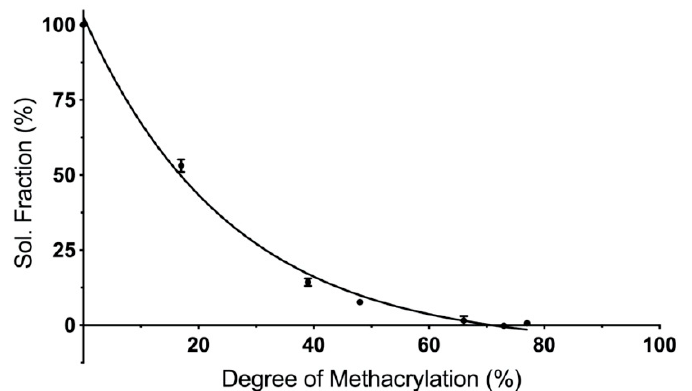
Figure 4. The influence of degree of methacrylation on the soluble fraction of cured PCLMA. Values displayed mean ± SD, N = 1, n = 3 (some SD values are too small for error bars to be visible).